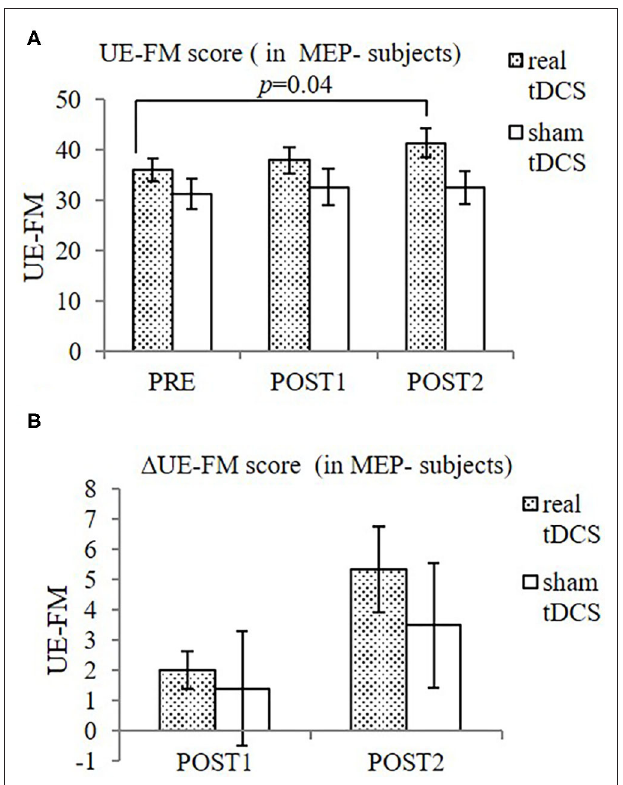
FIGURE 4 | RMT in the ipsilesional M1 (A) and contralesional M1 (B) . (A) Significant reduction in RMT in ipsilesional M1 in real-tDCS ( n = 6) group at POST1 and POST2, compared to PRE, but not in sham-tDCS group ( n = 5). The overall difference between groups was statistically significant. (B) No significant difference in RMT in contralesional side between two groups ( n = 10 for real-tDCS group, n = 9 for sham-tDCS group), or over time. Data shows mean ±